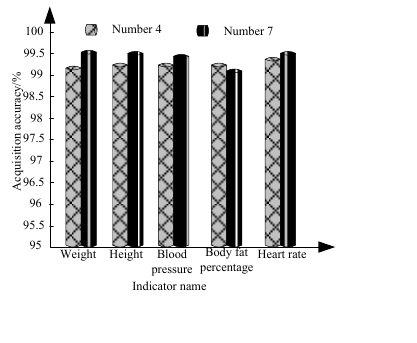
Figure 6. Data collection effect of telemedicine monitoring system